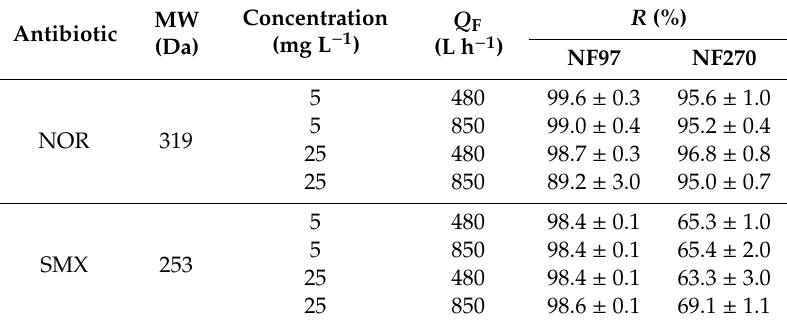
Table 5. E ff ects of the MW and concentration of the antibiotic and of the feed flow rate on the rejection for NF97 and NF270